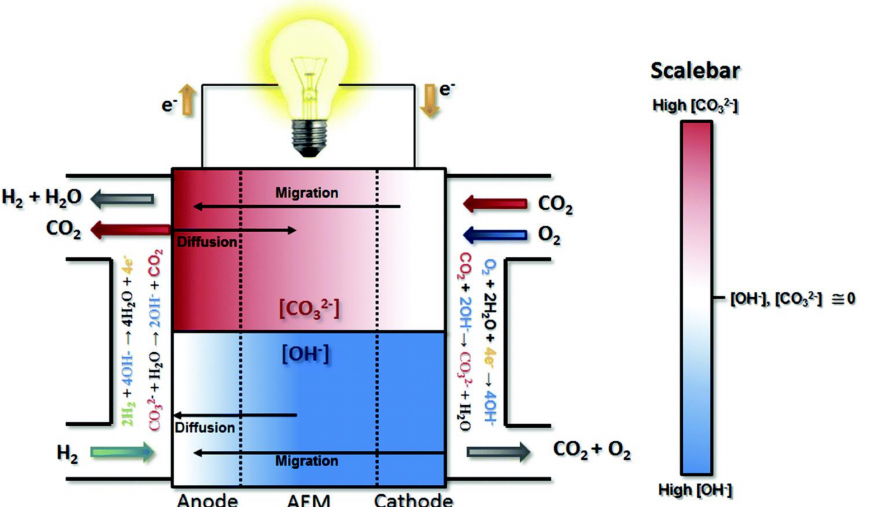
Figure 5. Schematic diagram of carbonate and hydroxide transport and distribution in an AEMFC operating with CO 2 present in the cathode reactant gas. The upper section of the diagram isolates the CO 3 2 behavior of the operating cell with a color gradient representing the concentration gradient. The upper section of the diagram shows the OH − concentration gradient and hydroxide migration and diffusion direction (Reprinted with permission from ref. [83] Copyright 2019 Royal Society of